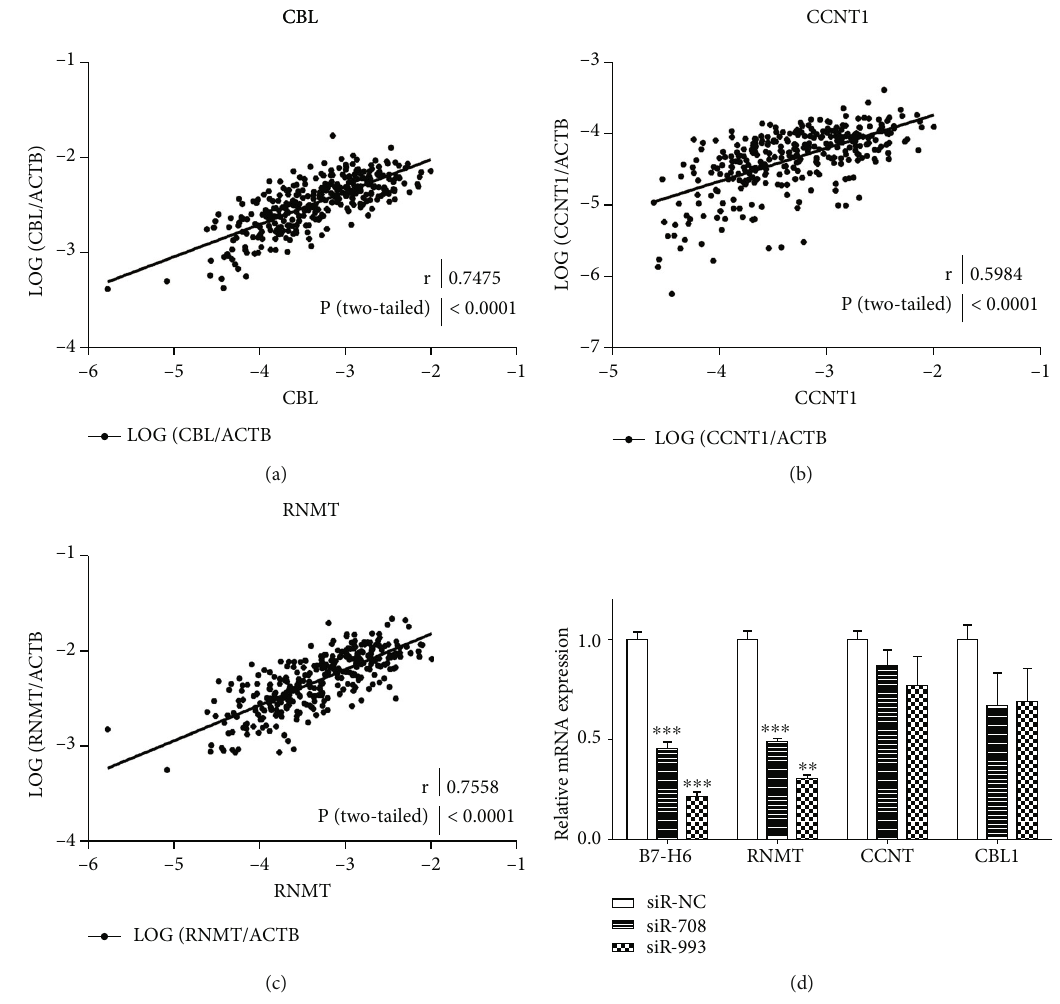
Figure 4: RNMT is a speci fi c gene coexpressed with B7-H6 and MYC. (a, b, c) Pearson correlation analysis was performed between the mRNA expression of B7-H3 and c-Myc based on CGGA mRNA-Seq database ( n = 325 ). (d) mRNA expression of B7-H6, RNMT, CCNT, and CBL1 was evaluated by RT-PCR in GSLCs transfected with siR-NC, siR-708, or siR-993, respectively ( n = 3 ). Data of (d) were mean ± SD . ∗ P < 0 : 05 , ∗∗ P < 0 : 01 , and ∗∗∗ P < 0 : 005